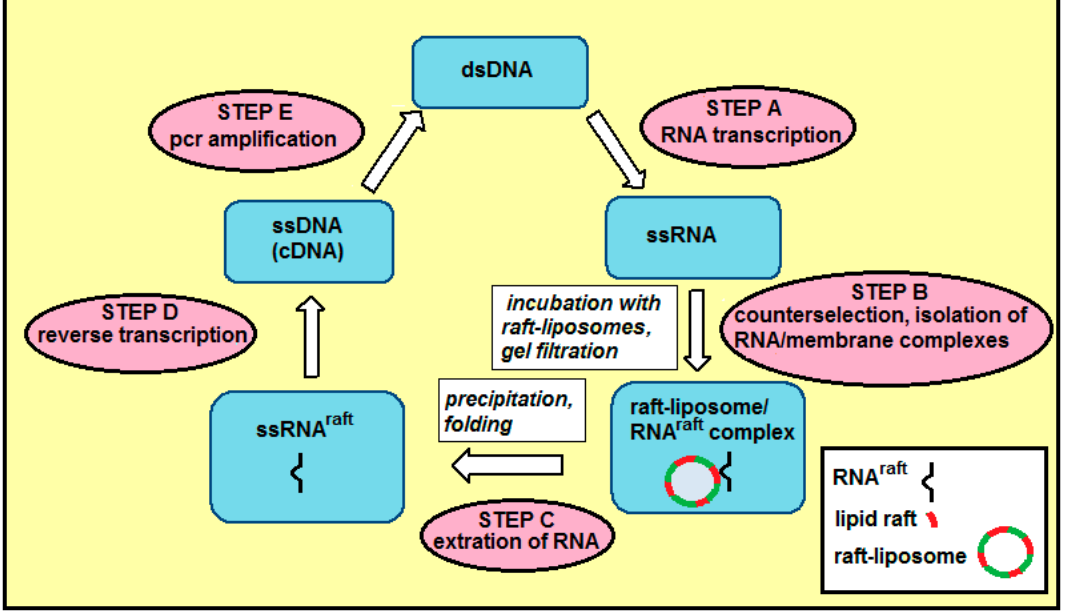
Figure 8. Steps of the selection-amplification (SELEX) method applied for RNA aptamers specific for membrane lipid rafts.